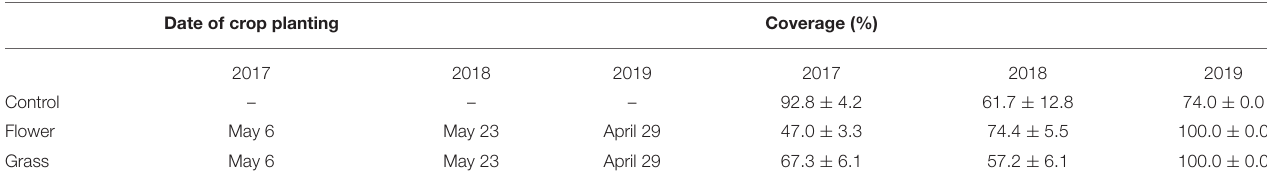
TABLE 1 | Date of cover crop planting and percent area occupied by cover crops in the between-row space of orchards in Yanqing and Changping at 8 weeks after planting (July). Date of crop planting Coverage